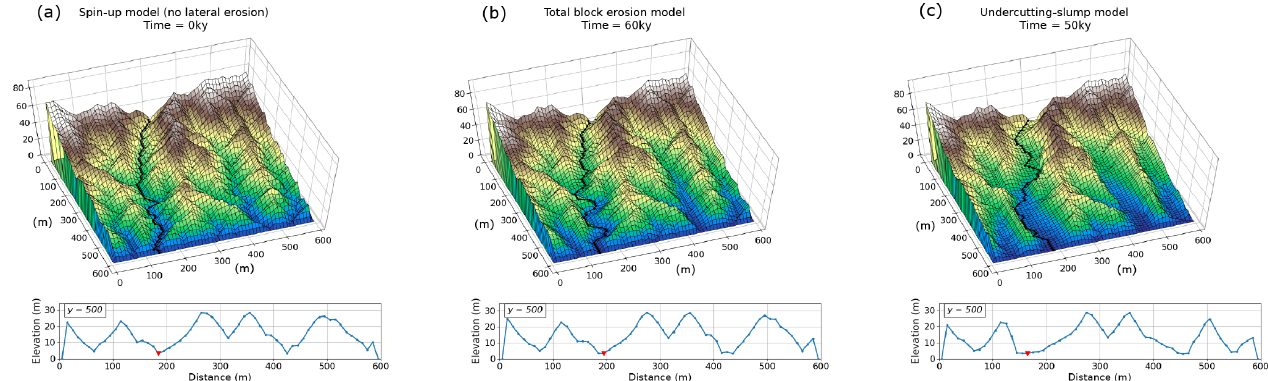
Figure 5. Model topography and cross sections at y = 500 showing examples of valley widening. The black line indicates the position of the main channel on the landscape. The red triangle shows the position of the main channel in the cross section. (a) Model with vertical incision only. (b) Total block erosion model after 70kyr of lateral erosion. (c) Undercutting-slump model after 50kyr of lateral erosion.